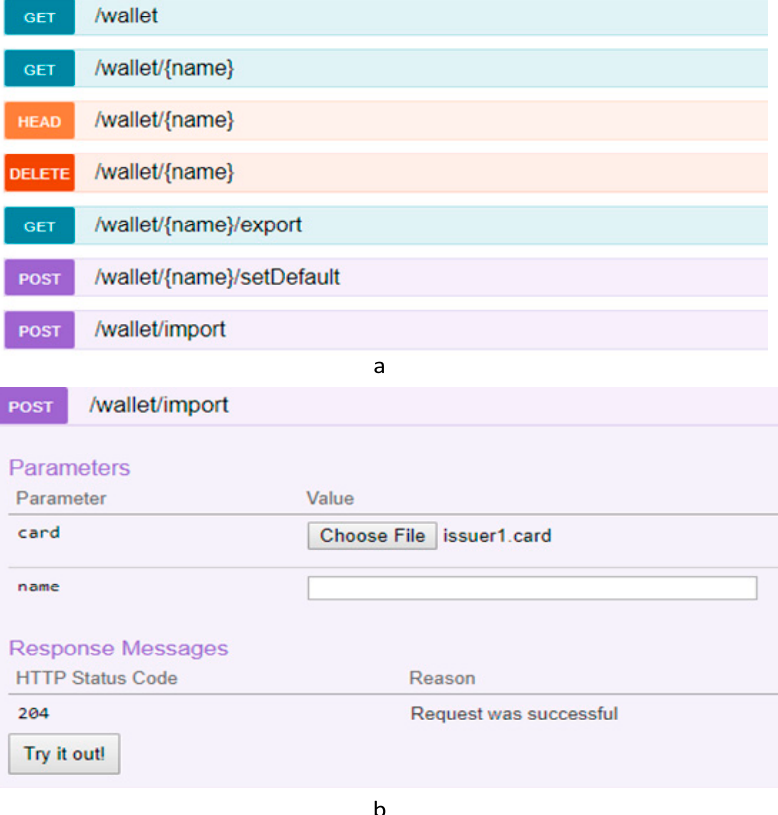
Figure 16. Snapshot of the wallet API. ( a ) Wallet API specifications; ( b ) add a business network card to the wallet.